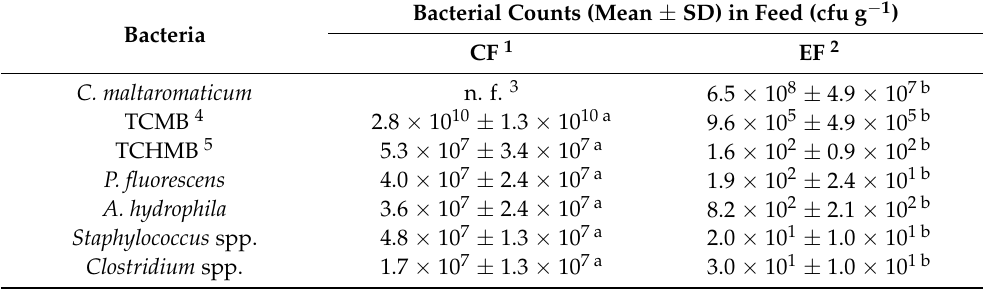
Table 3. Bacterial counts (mean ± SD, n = 14) in juvenile rainbow trout administered commercial feed (CF) (Aller Gold) and experimental feed (EF) (Aller Gold supplemented with 0.1% of the Carnobacterium environmental probiotic strain). The numbers marked with different superscript letters differ significantly (ANOVA; p < 0.05; n = 14).